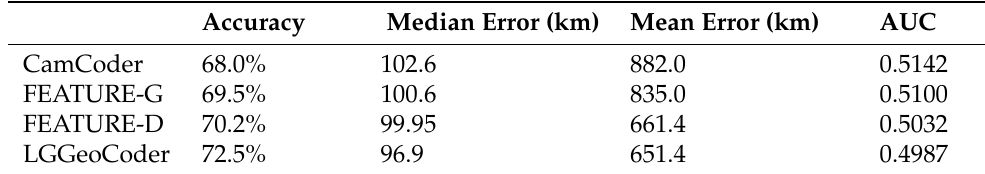
Table 3. The prediction performance of ablation